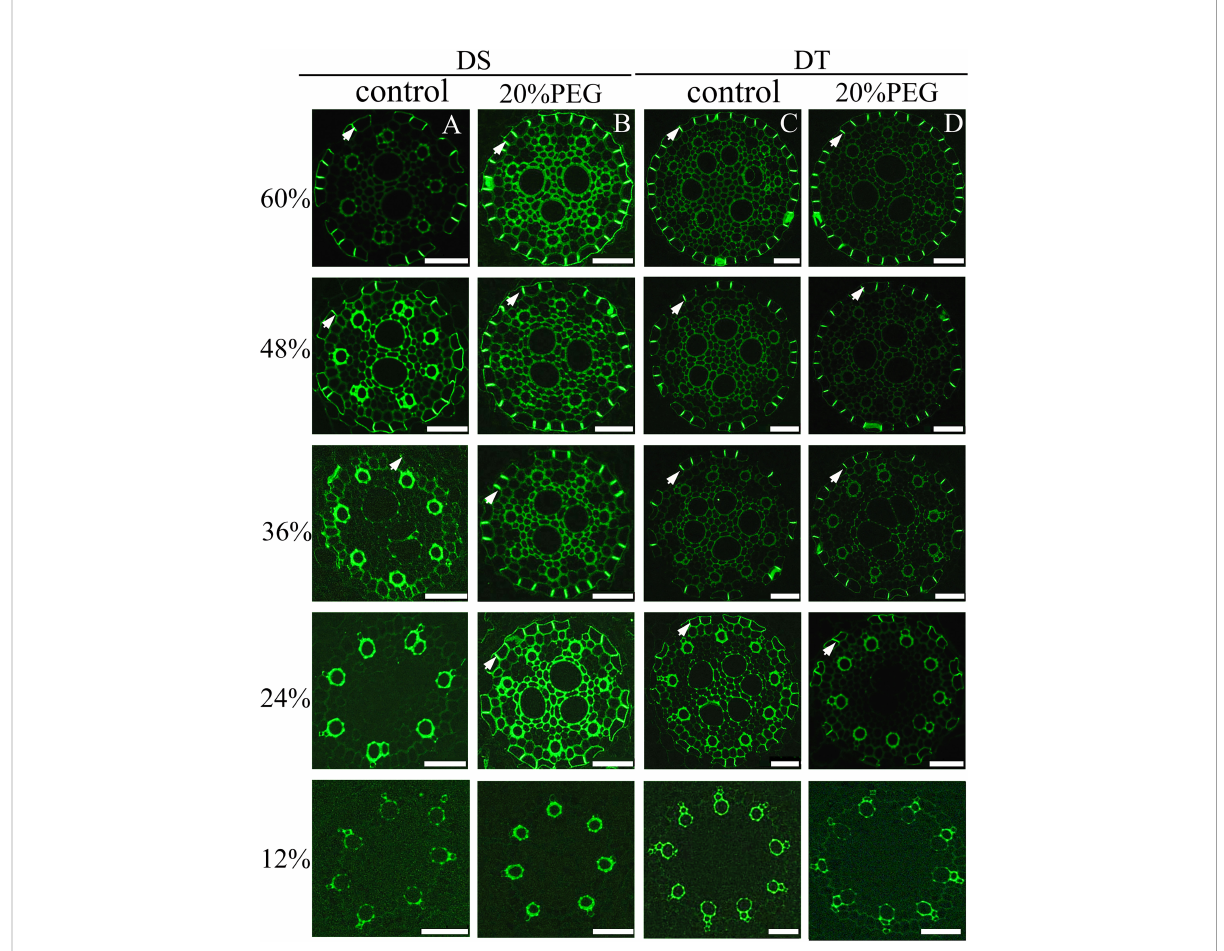
FIGURE 4 Fluorescence staining of Casparian strip (CS) in seminal roots of drought-tolerant (DT) and drought-sensitive (DS) genotypes grown under control or osmotic stress conditions. CS in seminal roots were stained with berberine hemisulfate for control DS (A) , osmotic-stressed DS (B) , control DT (C) , and osmotic-stressed DT (D) . Green fl uorescent spots (white arrow) indicate the CS. Numbers on the vertical axis represent the distance from the tip as a percentage of the total root length (scale bars, 42.5